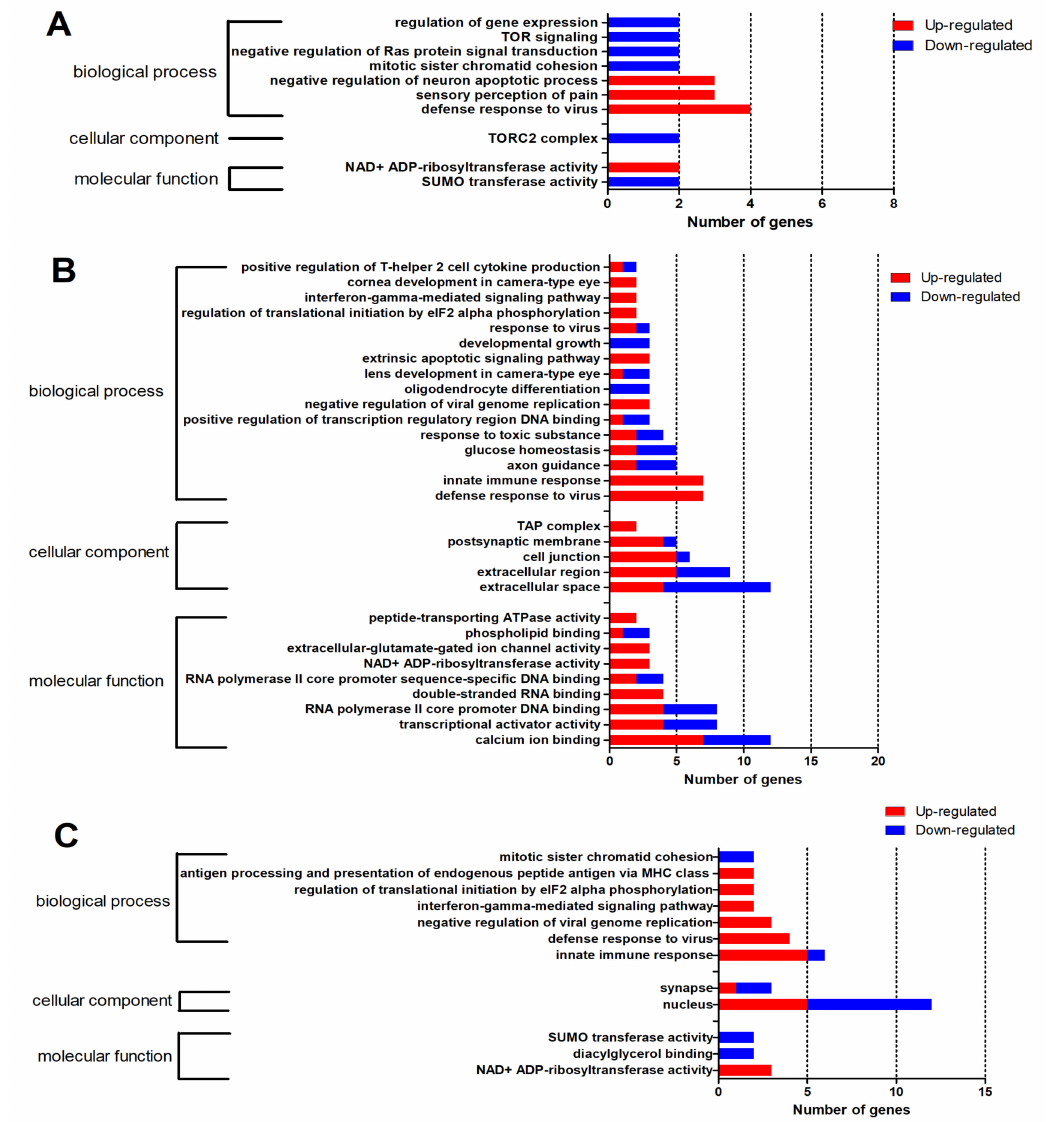
Figure 4. Gene ontology (GO) enrichment analysis of DEGs ( p < 0.05). ( A ) Ten GO terms significantly enriched at 12 hpi. ( B ) Thirty GO terms significantly enriched at 24 hpi. ( C ) Twelve GO terms significantly enriched at 48 hpi. The red portion of The bar represents The number of upregulated genes, and The blue portion of The bar represents The number of downregulated